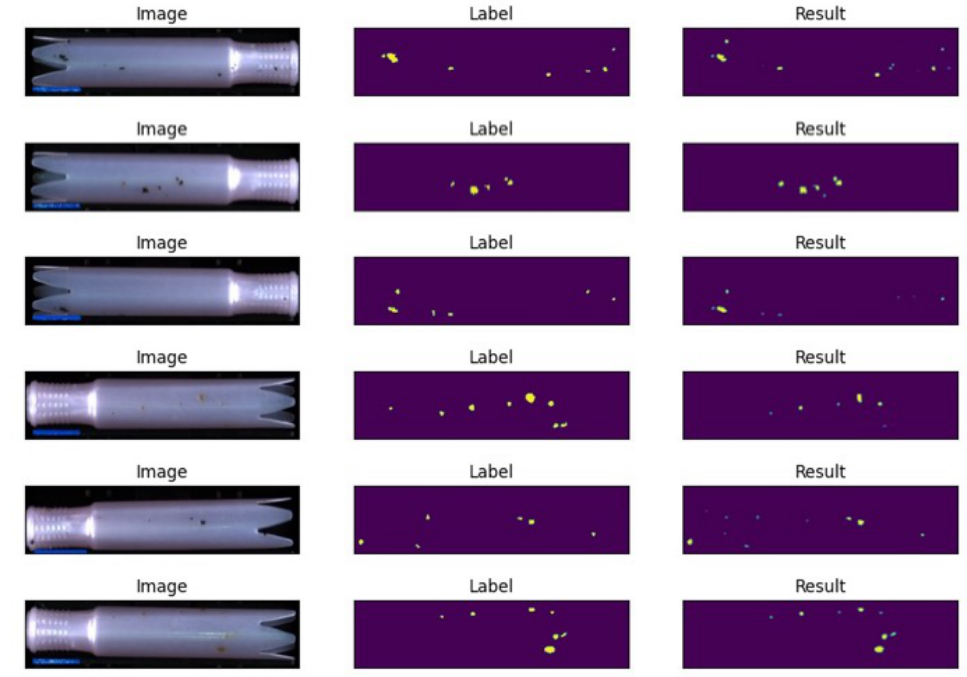
Figure 20. The examples of instance segmentation.